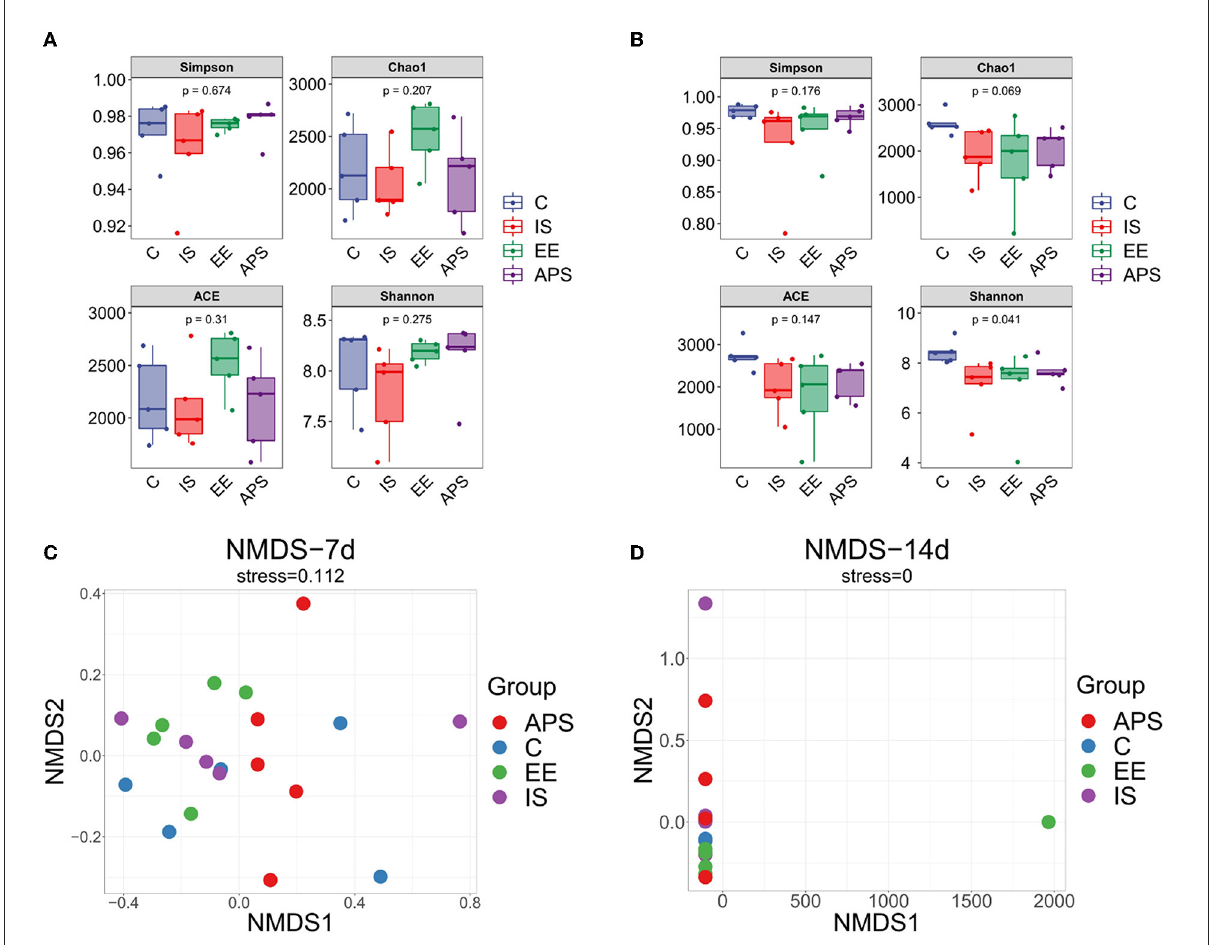
FIGURE1 Diversity analysis result. Alpha diversity index difference box plot (A) 7d; (B) 14d. NMDS analysis plots (C) 7d; (D) 14d ( N = 5).